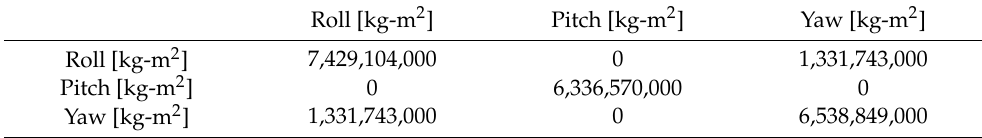
Table 9. 5CP inertia about objective’s center of mass.